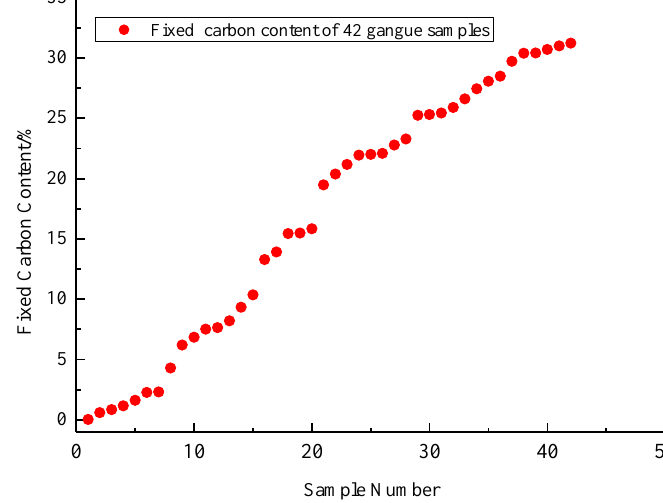
Figure 2. Diagram of the fixed carbon content of 42 gangue samples.